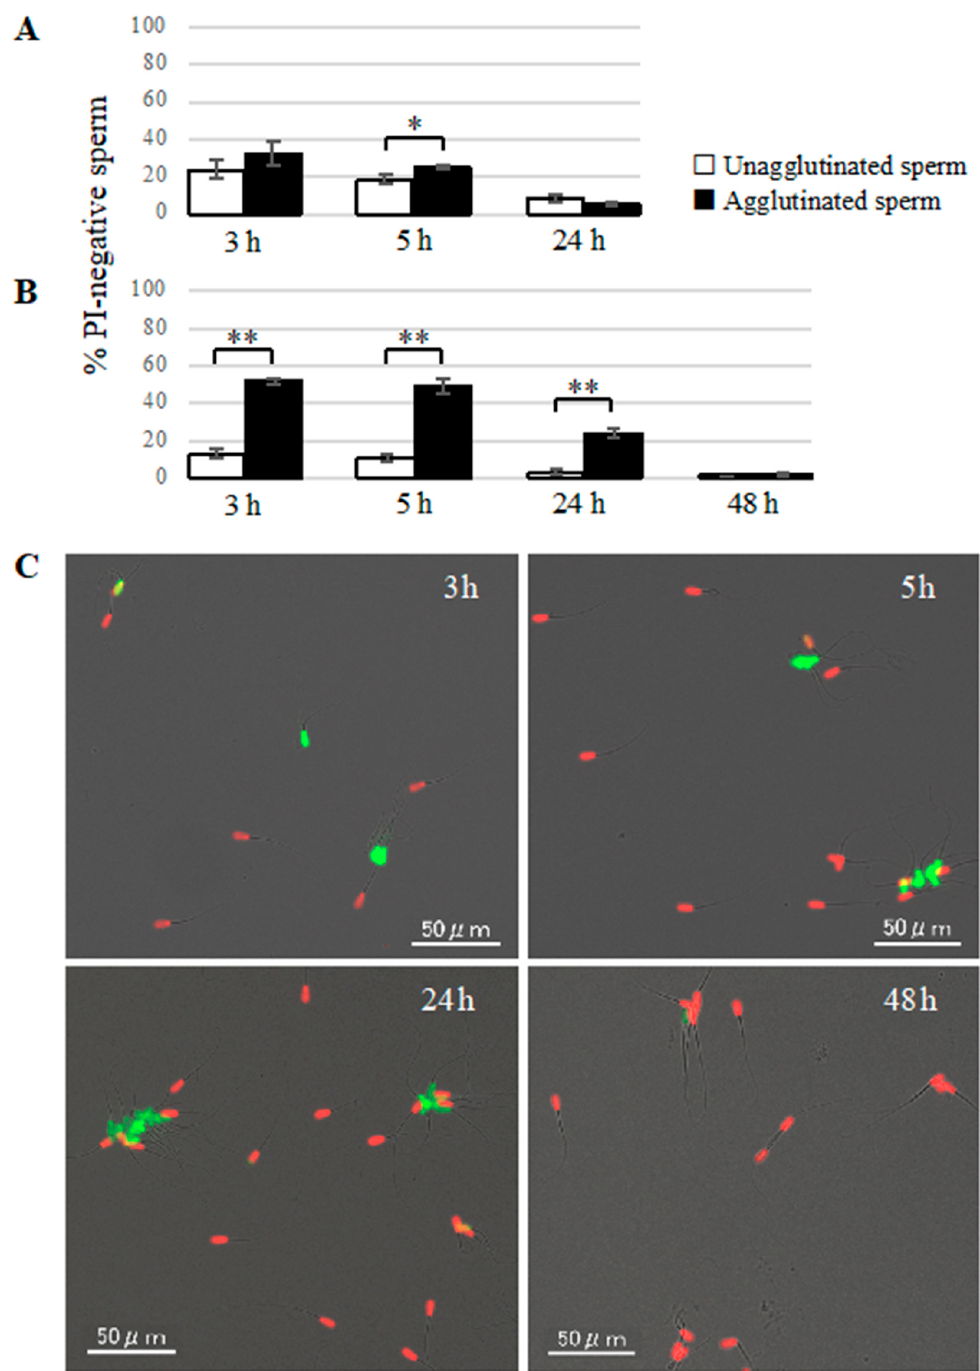
Figure 3. Viability of agglutinated and unagglutinated sperm. ( A , B ) Temporal changes in the % of PI-negative sperm in agglutinated or unagglutinated sperm. Sperm viability was evaluated by SYBR14 / PI staining at 3, 5, 24, or 48 h of incubation in capacitation medium ( A ), and non-capacitation medium ( B ). White bars show the % of PI-negative cells in unagglutinated sperm, and black bars show the % of PI-negative cells in agglutinated sperm. Data shown as mean ± SE ( n = 4; * p < 0.05; ** p < 0.01). ( C ) Representative images of sperm stained with SYBR14 / PI incubated for 3, 5, 24, or 48 h in non-capacitation medium. Green: SYBR14 (live sperm); Red: PI (dead sperm). Bars = 50 μ m.